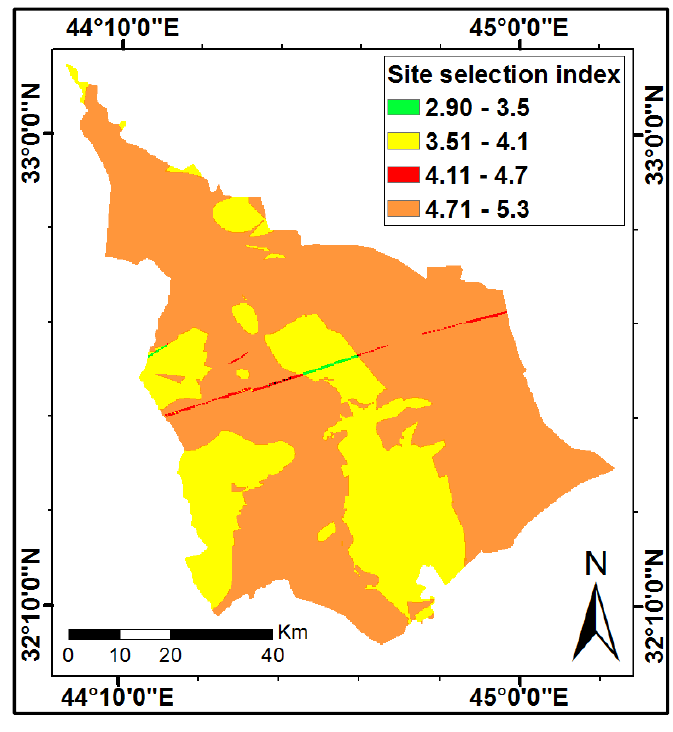
Figure 11. Site selection map.